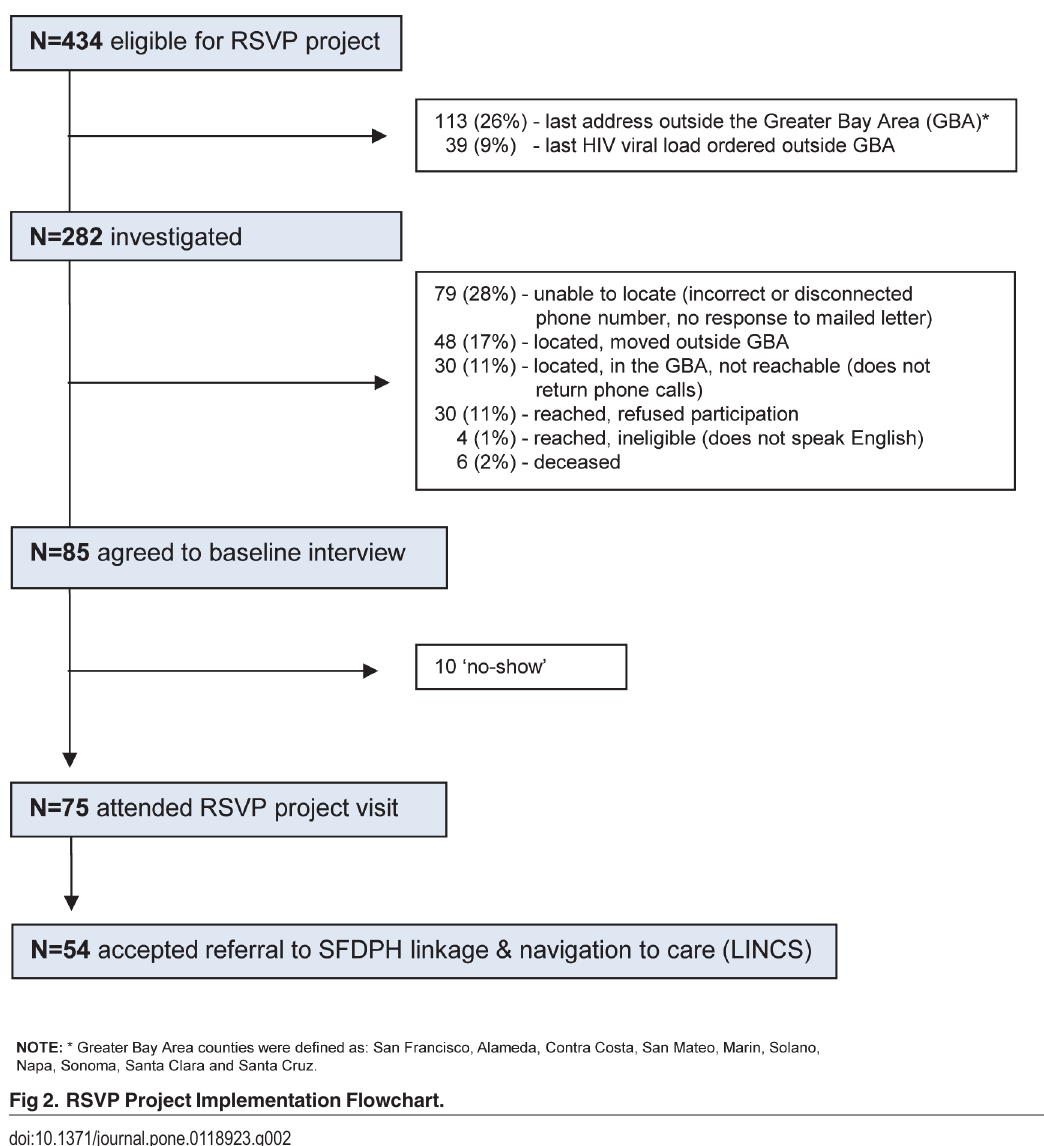
Fig 2. RSVP Project Implementation